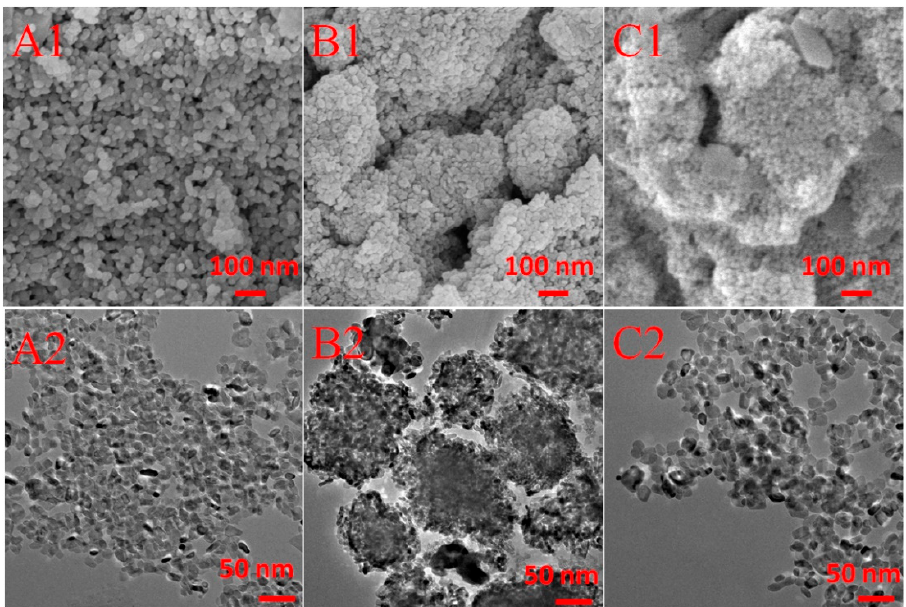
Figure 3. The SEM ( A1 – C1 ) and TEM ( A2 – C2 ) images for the powdery catalysts produced by different titanium precursors: (A) filter cake, (B) titanium dioxide, and (C) filter cake plus titanium dioxide.